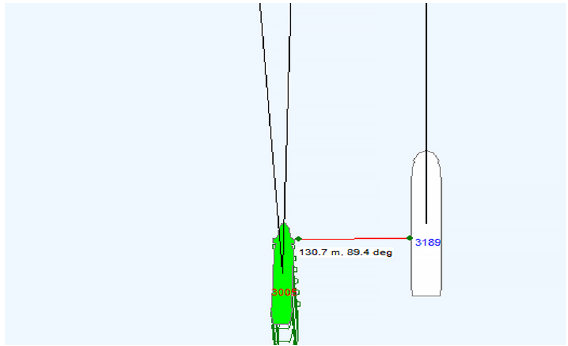
Fig. 12. Scheme for the PANAMAX tanker and a ferry sailing in parallel directions and the distance between the ships (wind direction perpendicular to the courses of the ships, velocity 12 m/s)